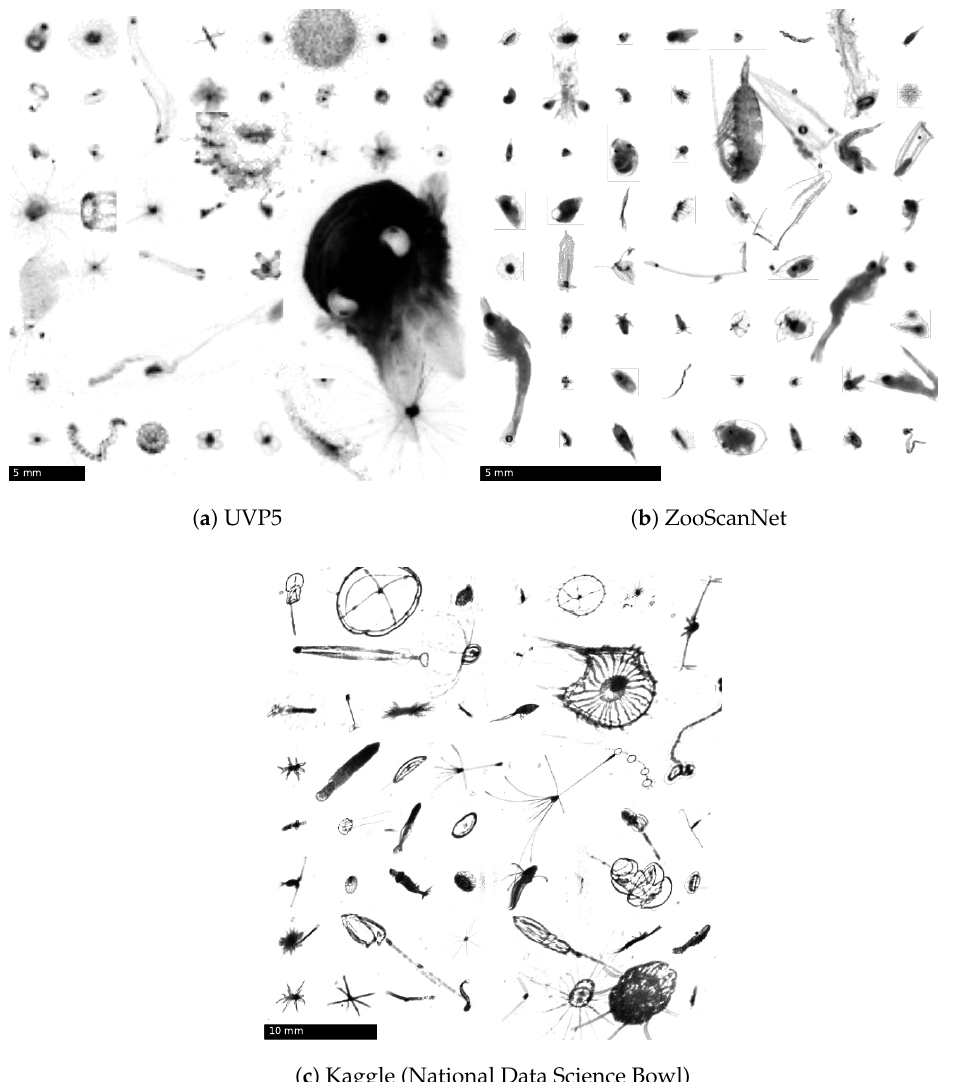
Figure 2. Mosaics of plankton image datasets. Objects were randomly sampled from the datasets and arranged in an aesthetically pleasing manner. UVP5 ( a ) © Kiko and Schröder 2020, CC BY-NC [30]. ZooScanNet ( b ) © Elineau et al.2020, CC BY-NC [31]. Kaggle ( c ) © Cowen, Sponaugle, Robinson and Luo, Oregon State University, 2015 [56]. Reproduced with permission from the